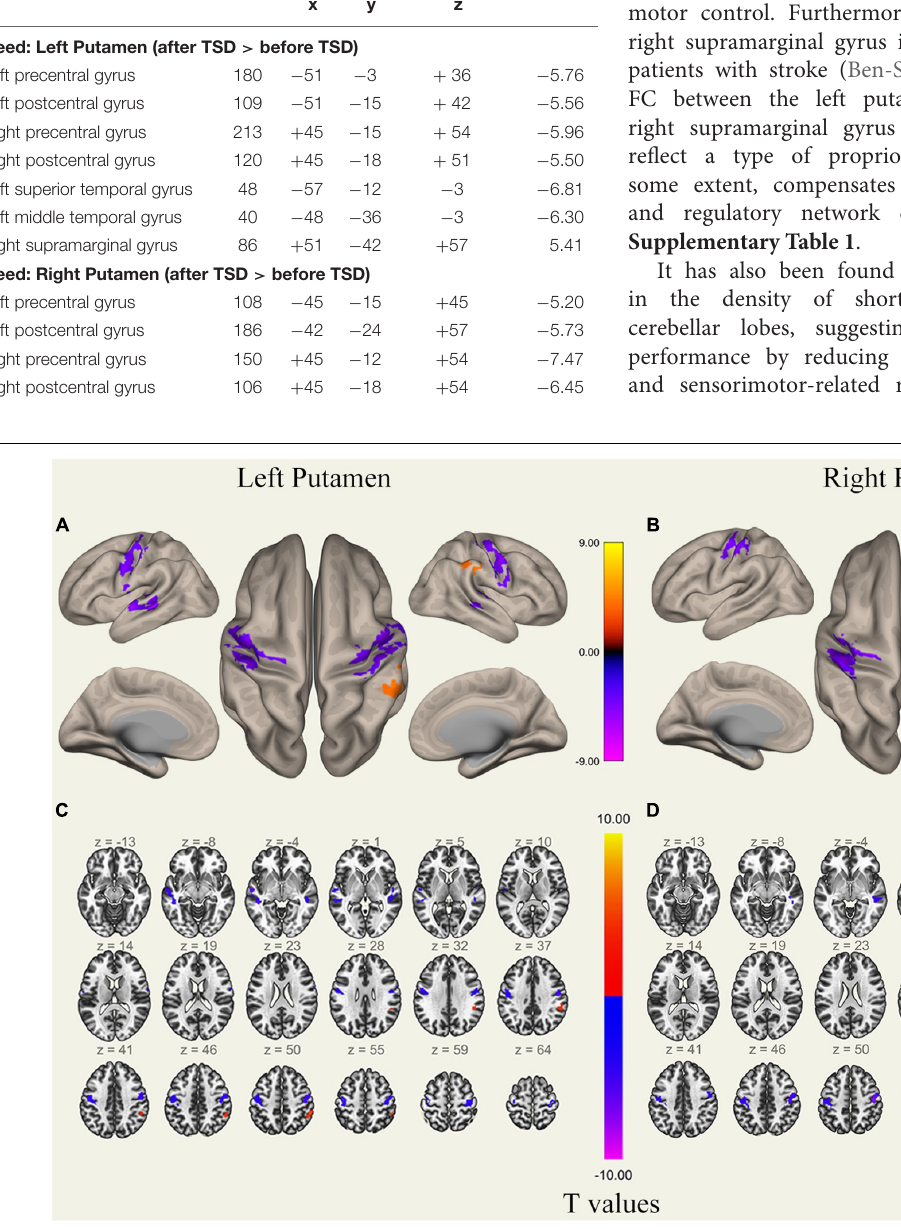
Frontiers in Neuroscience |